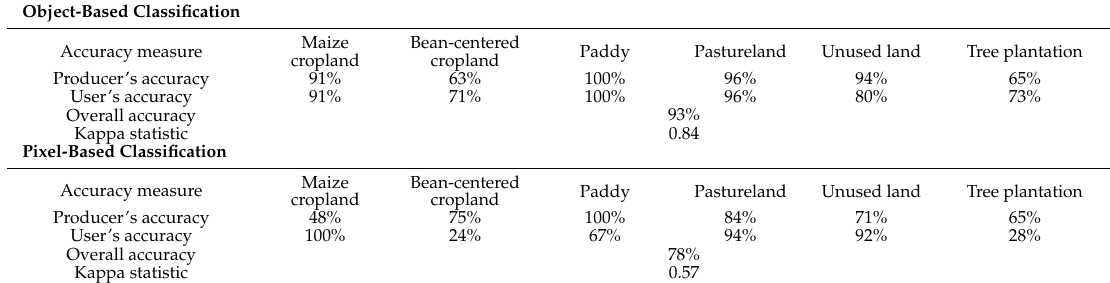
Table 1. Accuracy assessment of object-based and pixel-based classification